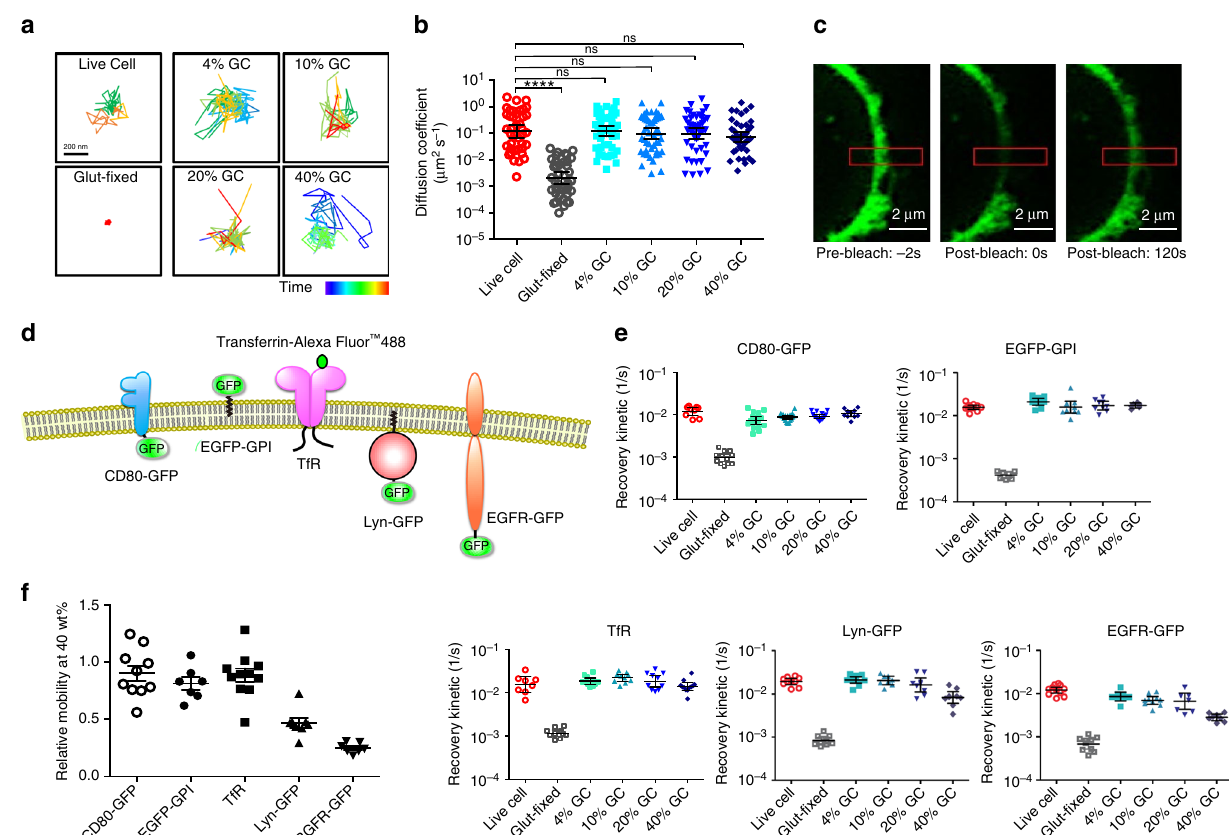
Fig. 4 Examination of membrane protein lateral mobility on GCs. a Representative trajectories from CD80-GFP fl uorescence tracking on different GCs and control cells examined by TIRF microscopy. b Diffusion coef fi cients of CD80-GFP were calculated from the TIRF fl uorescence tracking data. Error bars represent geometric mean with 95% con fi dence interval. c Representative images showing recovery of CD80-GFP fl uorescence in 4 wt% GC following photobleaching. Red rectangles indicate the photobleached area of interest. Scale bars = 2 μ m. d A schematic illustration of membrane proteins with different sizes of intracellular domains, including CD80-GFP, EGFP-GPI, TfR, Lyn-GFP, and EGFR-GFP, which were assessed for their lateral mobility on GCs. e Recovery kinetics of CD80-GFP, EGFP-GPI, TfR, Lyn-GFP and EGFR-GFP on GCs and control cells assessed by FRAP. For GCs with 4 to 20 wt% hydrogel densities, all examined membrane proteins had similar lateral mobility as on live cells. Error bars represent geometric mean with 95% con fi dence interval. f Membrane protein mobility on 40 wt% GCs relative to their corresponding mean mobility on live cells. Error bars represent geometric